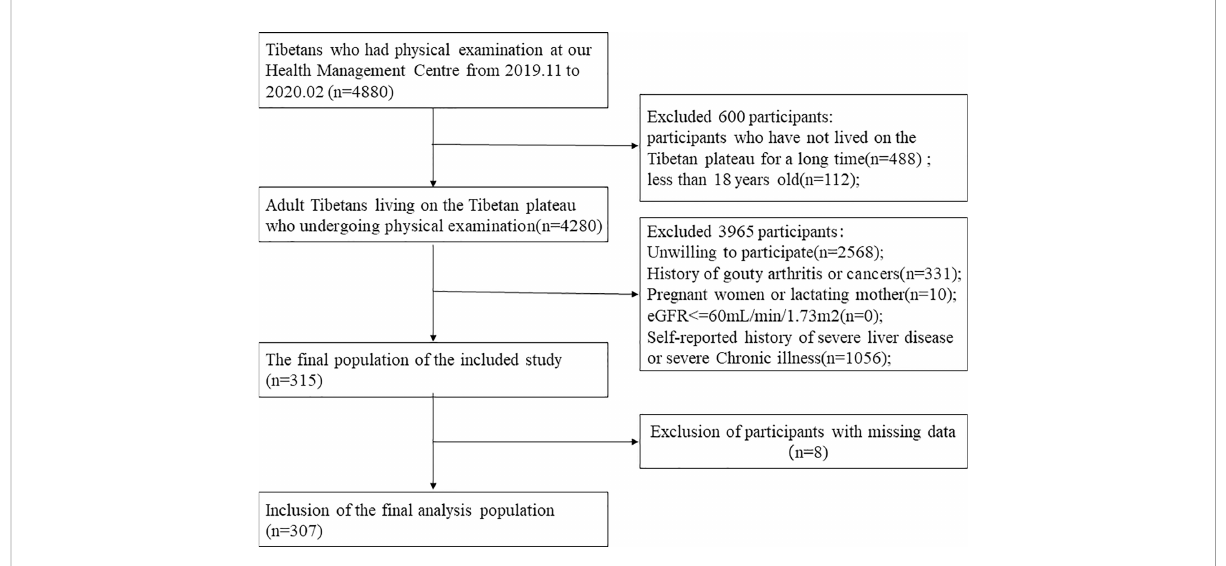
FIGURE 1 The association between Hyperuricemia and Metabolic syndrome. The Flow chart of the